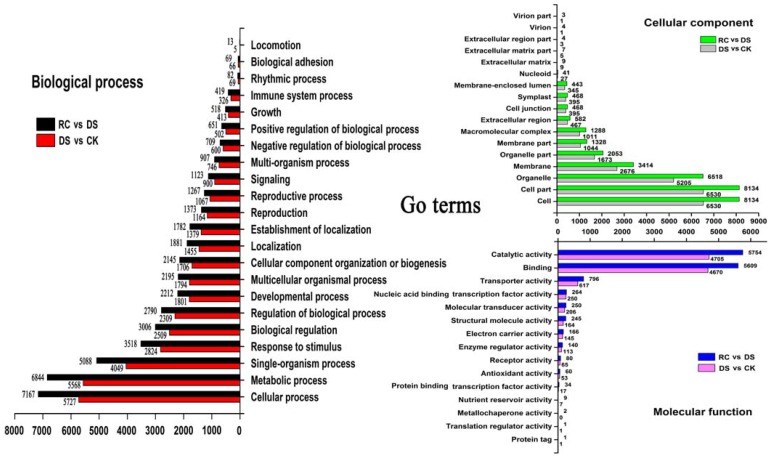
Function classifications of GO terms of Camellia sinensis transcripts.Based on highscore BLASTx matches in NR plant proteins database, a total of 35,304 unigenes were classified into three main GO categories and 31 sub-categories. Number of genes in a specific category within the main category is shown on y-axis; number of unigenes is shown in x-axis.